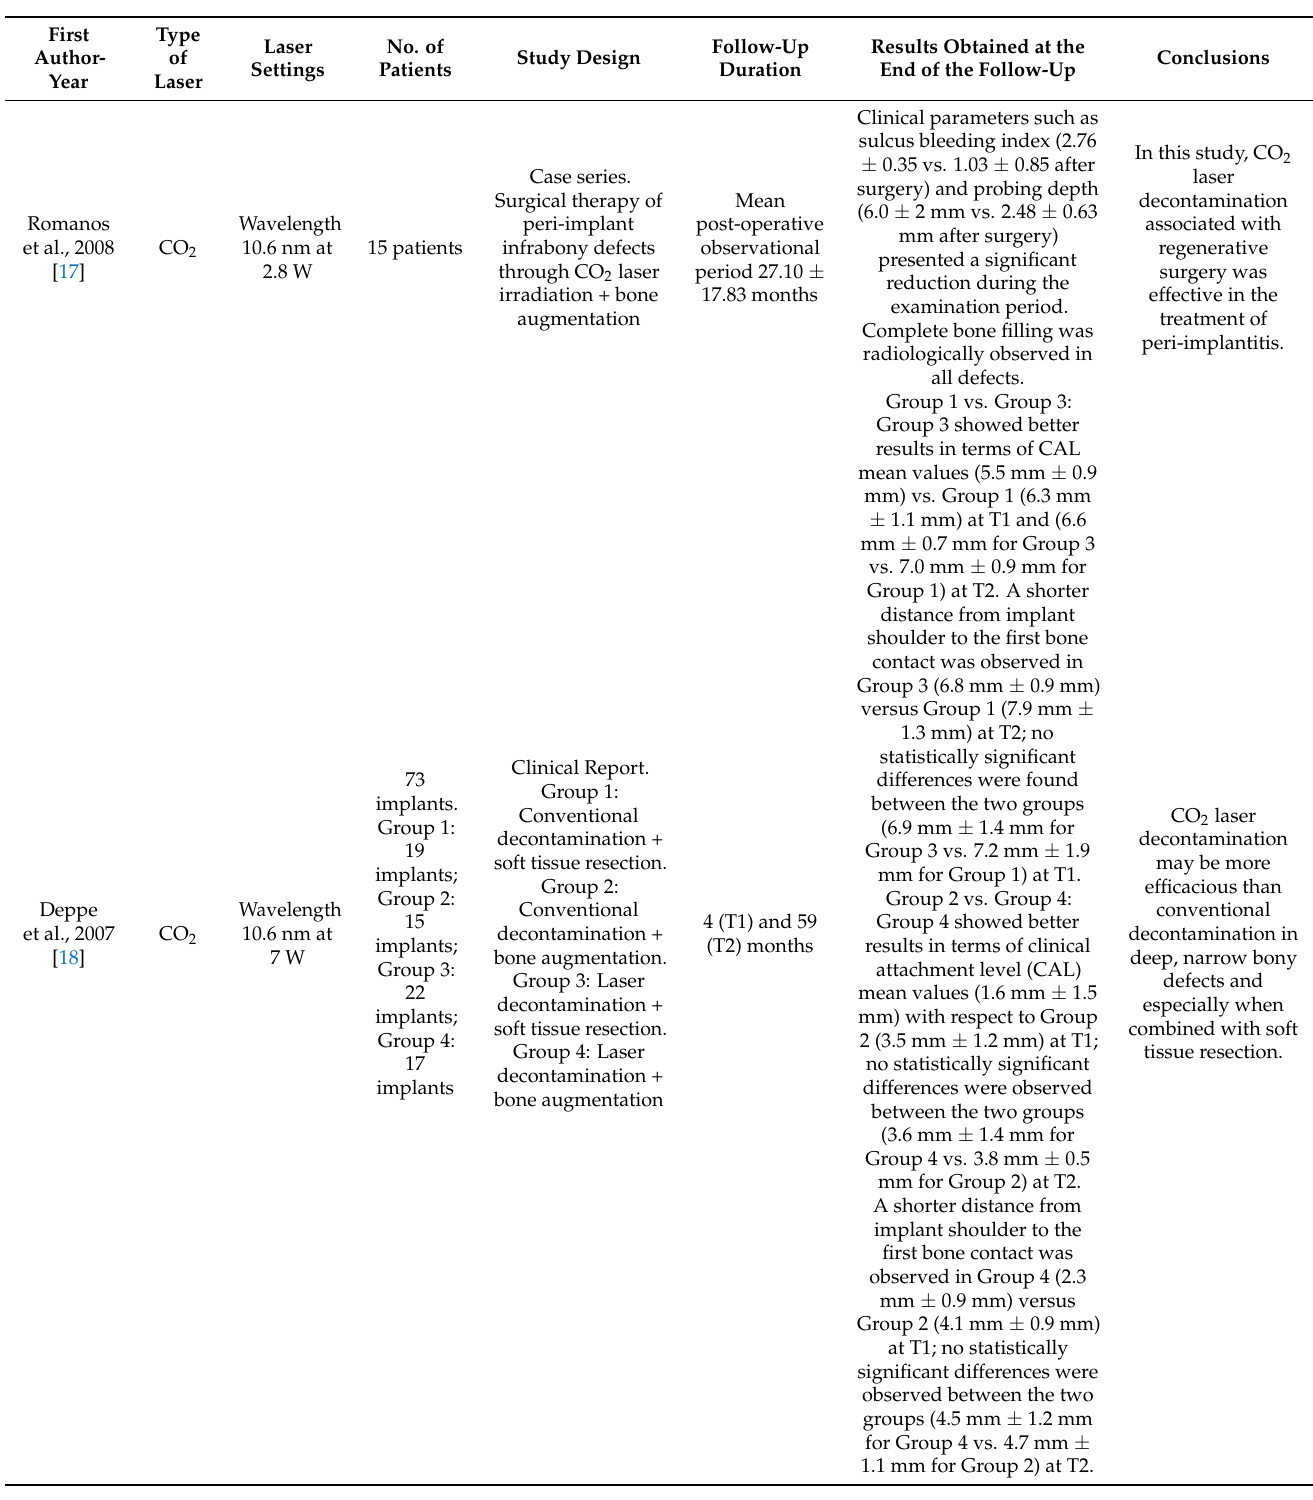
Table 2. Use of CO 2 laser in peri-implantitis